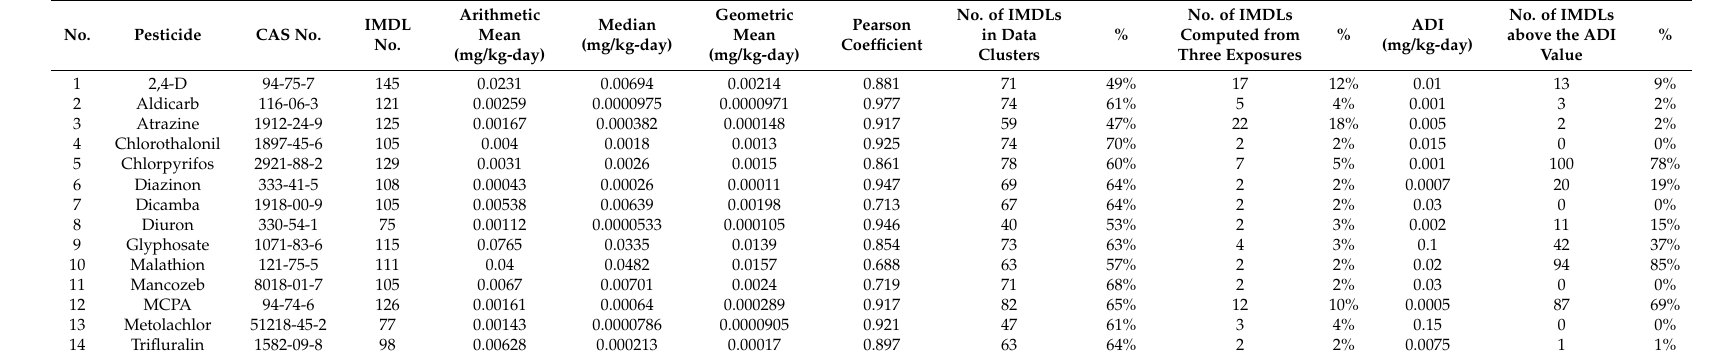
Table 8. Statistical summary of the IMDLs for the widely used